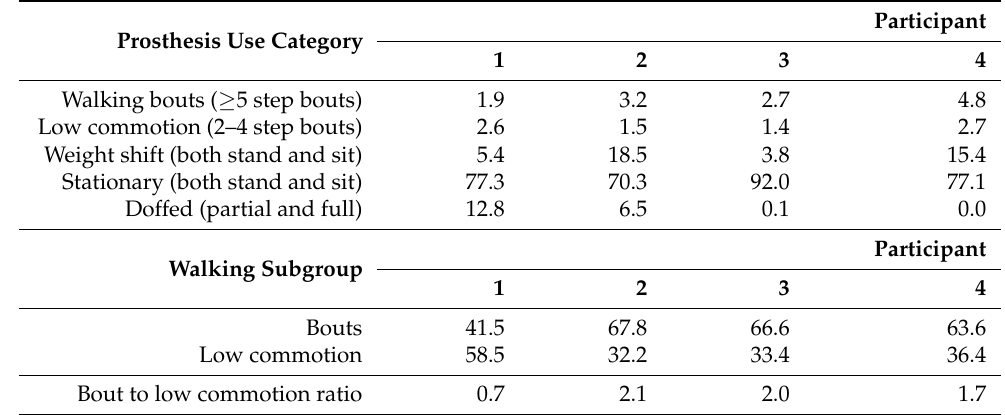
Table 3. Prosthesis use results. Upper table: Prosthesis use distribution during take-home testing. Lower table: Walking time distribution between bouts ( ≥ 5 steps) and low commotion (2–4 steps). Results are expressed as a percentage of the participant’s total walking